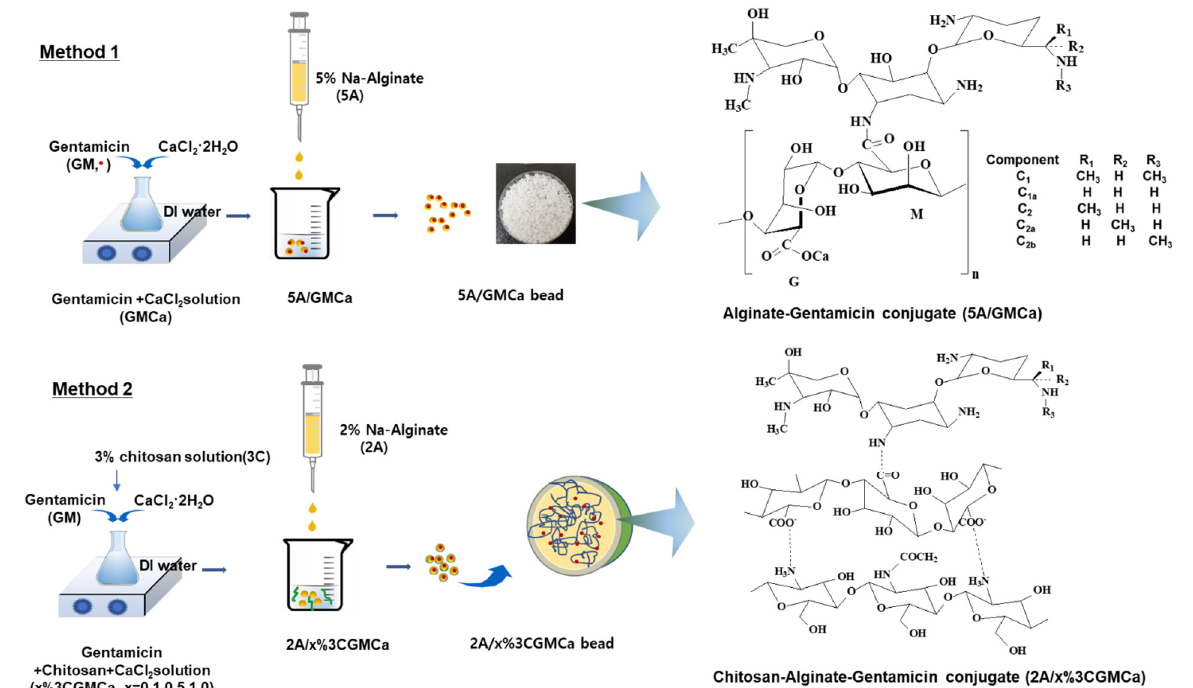
Scheme 1. Schematic illustration of reaction mechanism involved in the formation of alginate-gen- tamicin conjugate (5A/GMCa) and alginate-chitosan-gentamicin conjugate (2A/x%3CGMCa)